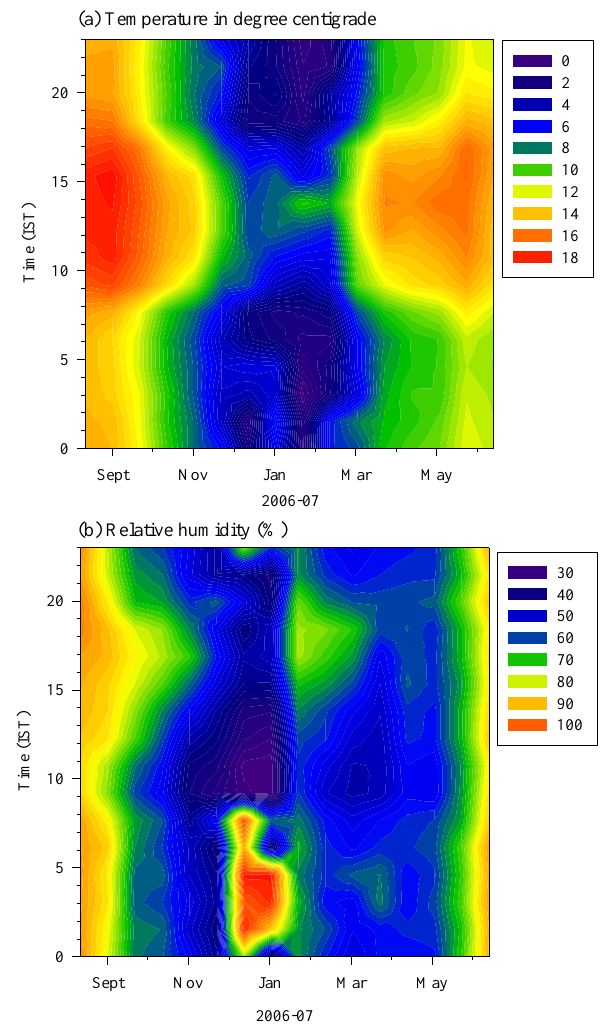
Fig. 2. Monthly mean diurnal and seasonal variation of (a) ambient air temperature (in degree centigrade) and (b) relative humidity (%) measured over the observational site during the study